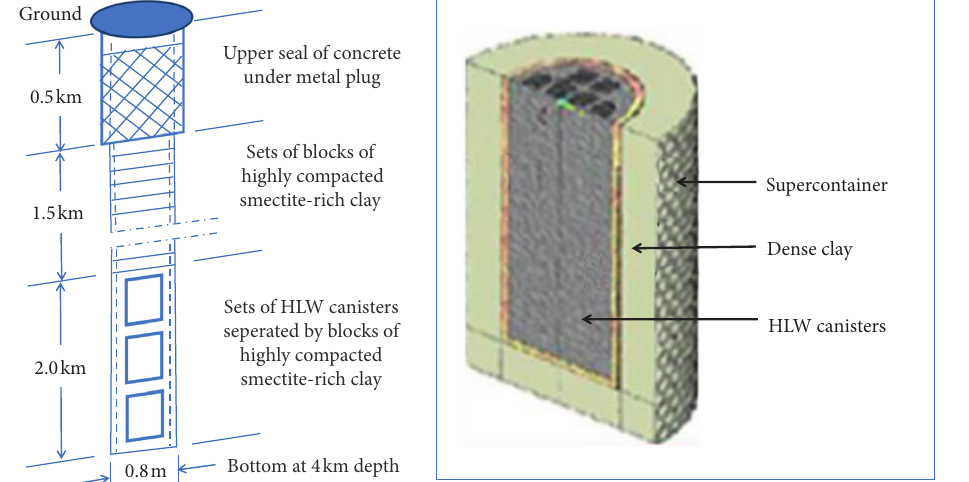
Figure 1: Schematic illustration of VDH concept. The package shown on the right consists of a supercontainer with a clay-embedded canister containing spent fuel [6,